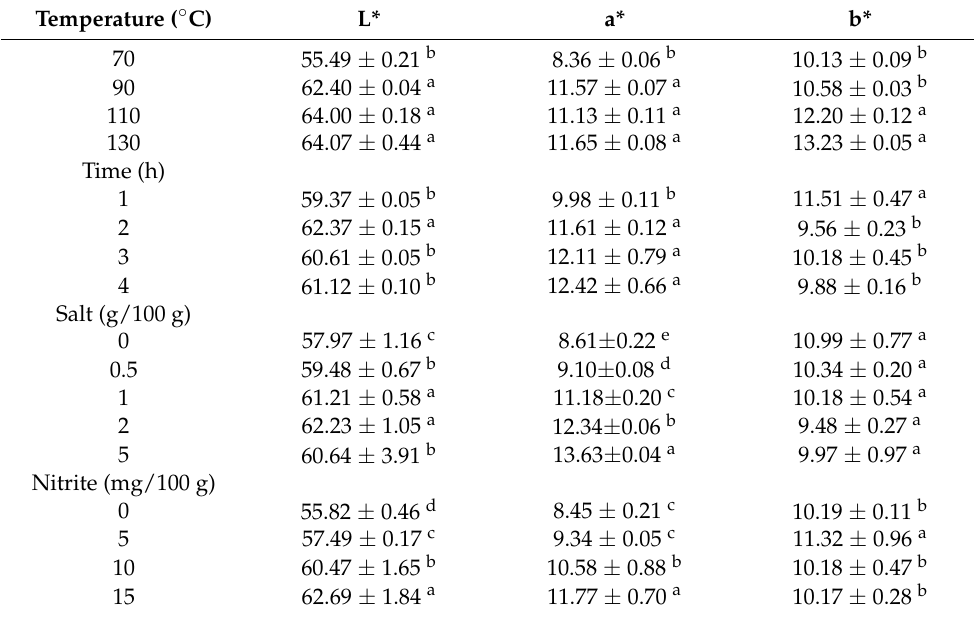
Table 3. Color values of sausages under different processing